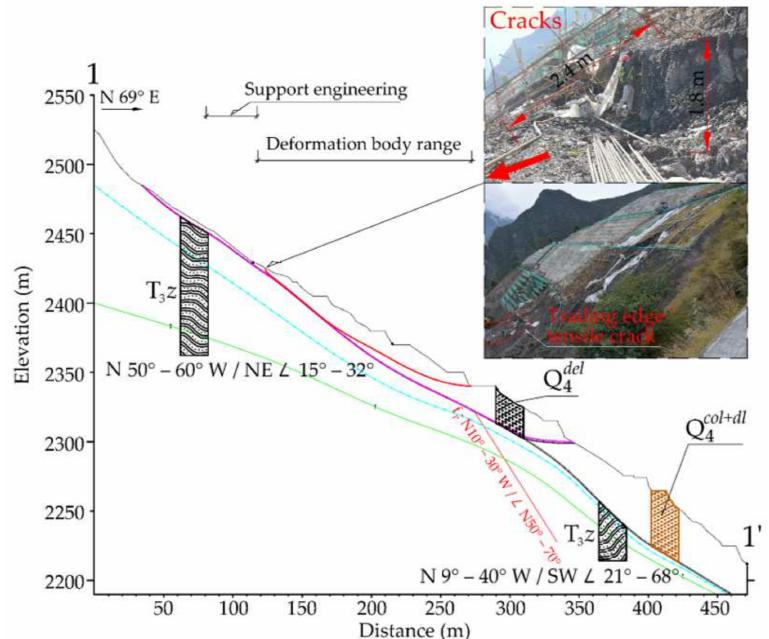
Figure 11. Geological engineering profile of Danbo accumulation (photograph taken on 4 November 2017).